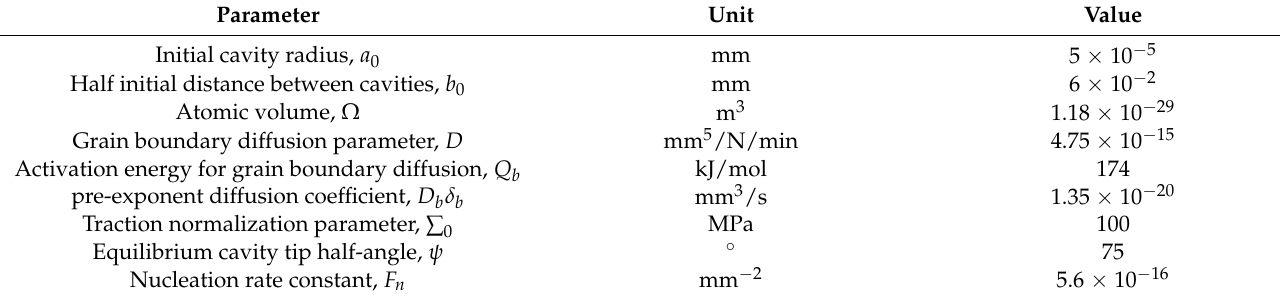
Table 2. Parameters of X12CrMoWVNbN10-1-1 related to cavity coalescence damage model [13,41,43].